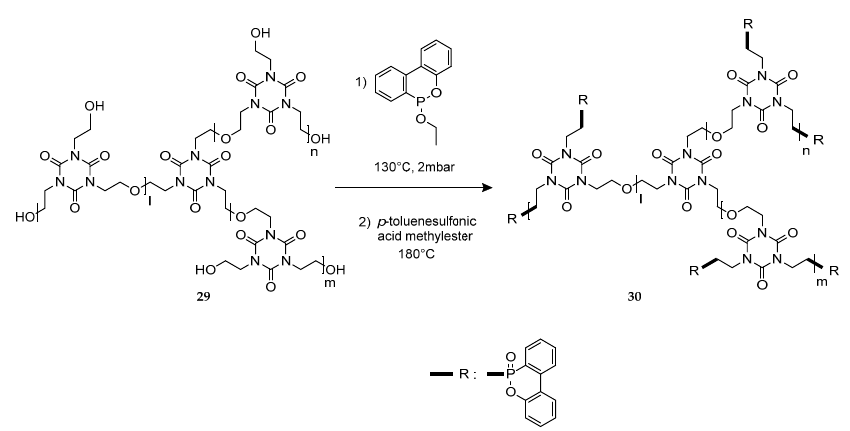
Figure 11. Various DOPO derivatives.